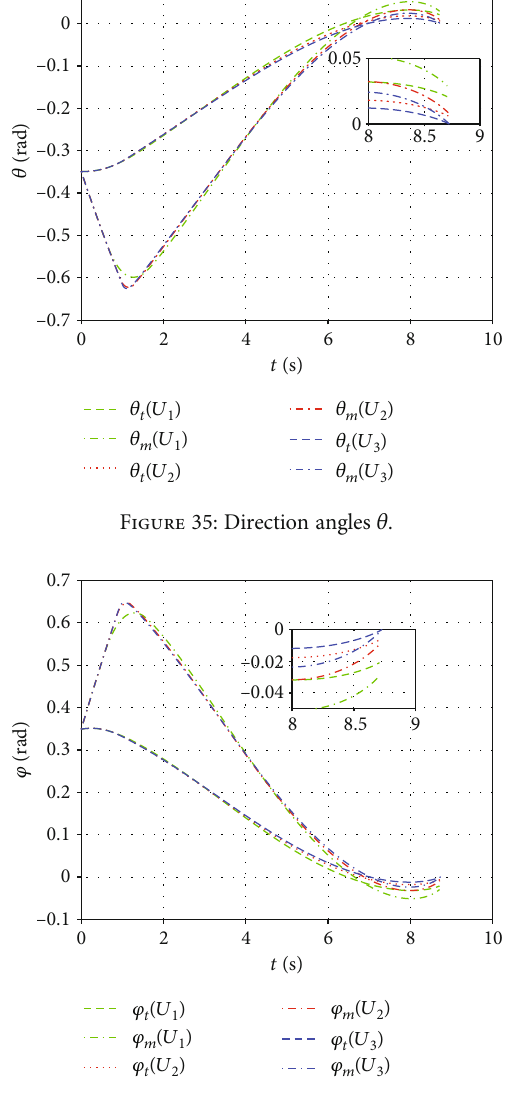
Figure 36: Direction angles φ .